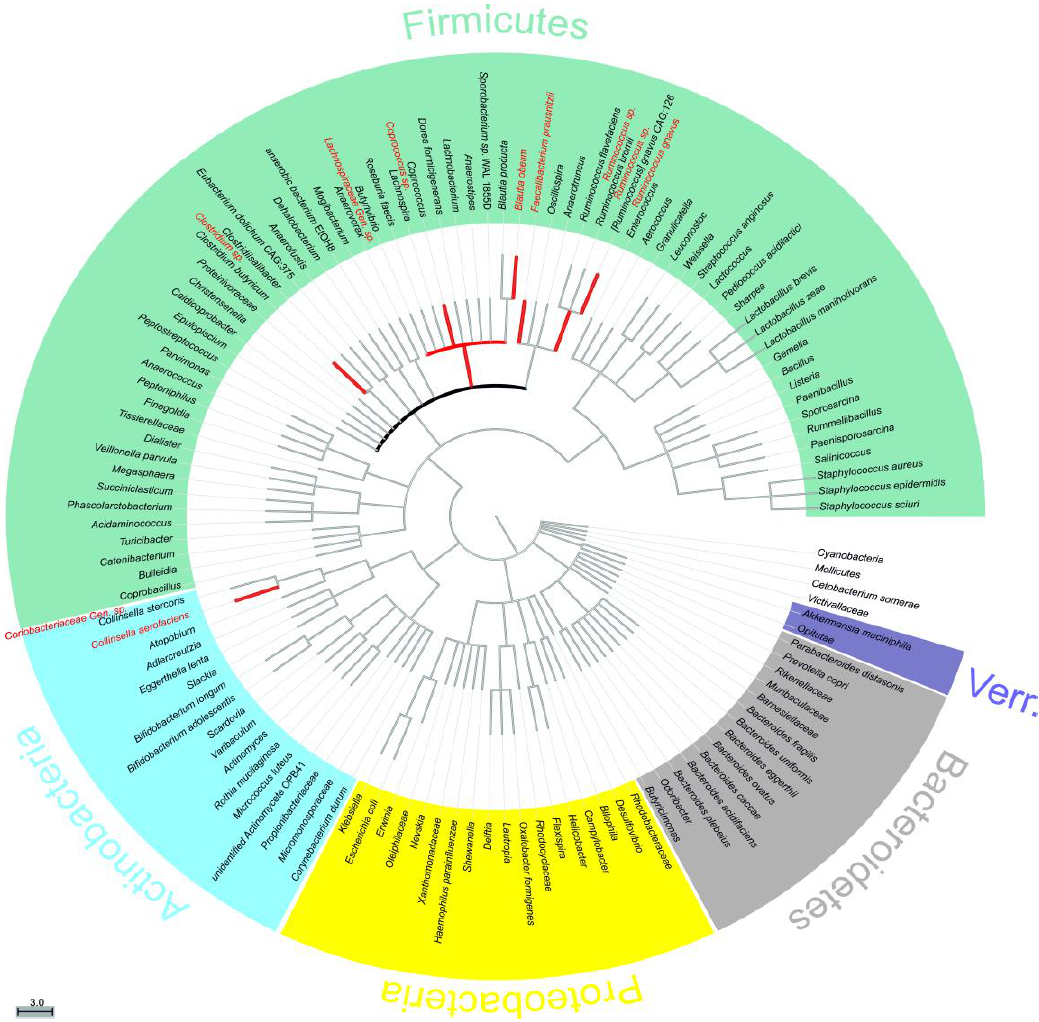
Figure 3. Phylogenetic tree of all identified bacterial entitites. The tree is sorted by phylogenetic distance, therefore the closer they are on the tree, the closer they are genetically [41,42]. Taxa shown in red displayed p < 0.075 for at least one p value (Paired sample t-test and/or Wilcoxon signed-rank test) for both comparisons 1 and 2. Bolded black line refers to family Lachnospiraceae. Verr. = Verrucomicrobia. Gen. = unnamed genus, sp. = unnamed